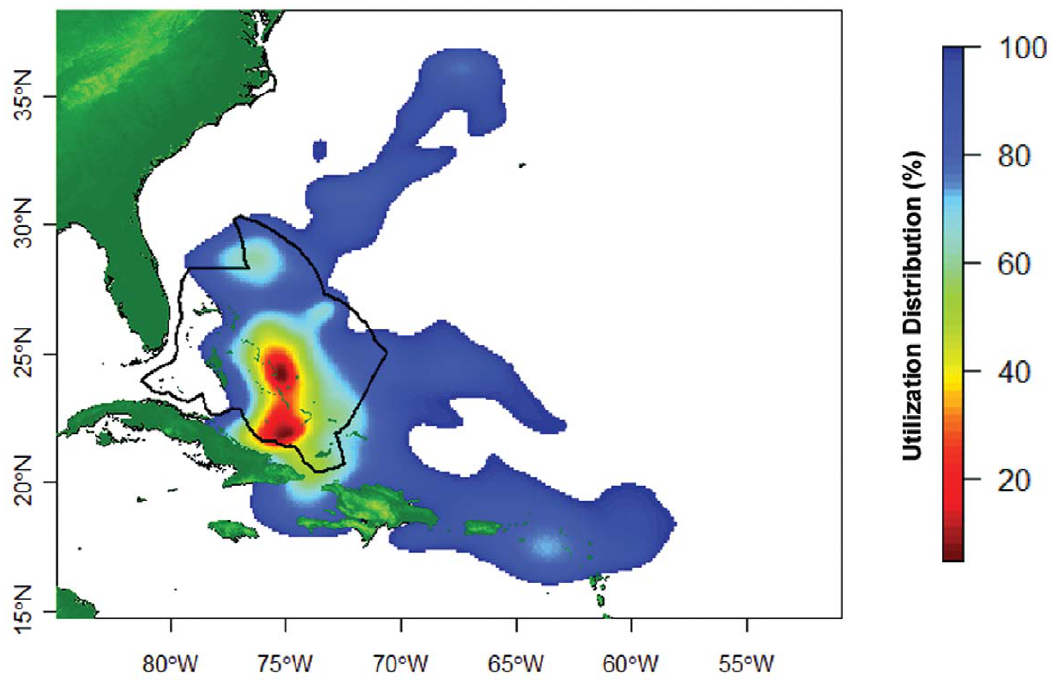
Figure 4. Map showing percent utilization distribution calculated from filtered daily geolocations from the eight individuals equipped with Standard Rate tags deployed at Cat Island, The Bahamas. Black line indicates the boundary of the Bahamian EEZ.